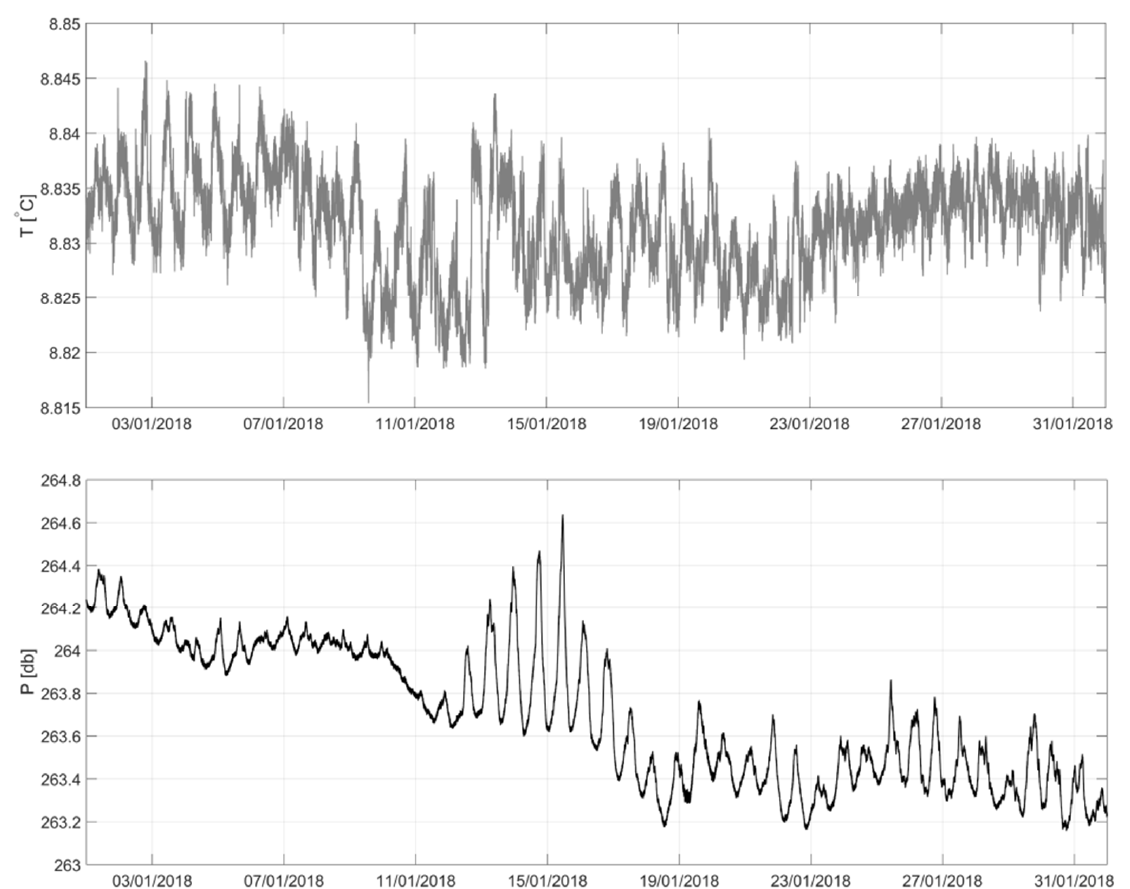
Figure A3. Temporal variability of sea temperature and pressure at 265 m in January, 2018, from the observations of ABS No. 2.